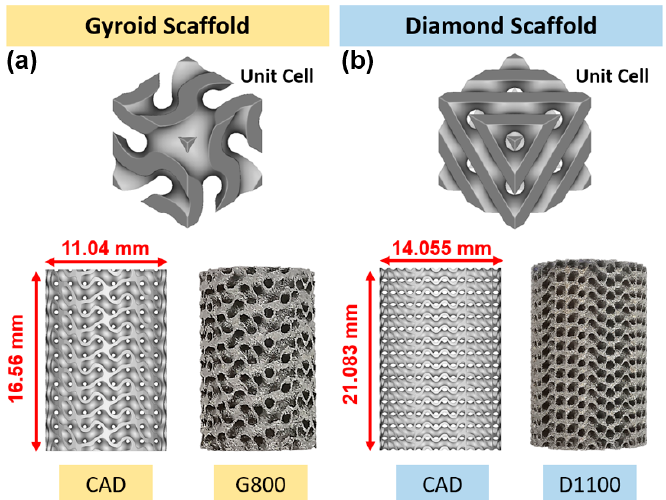
Figure 2. Three-dimensional-printed samples: ( a ) gyroid scaffold; ( b ) diamond scaffold. Sheet thickness and porosity of the TPMSs were kept constant at 300 μ m and 62%, Schoen gyroid unit respectively, for both gyroid and diamond scaffolds. Pore size was defined as the inter- connected pore size, which is the diameter of a sphere that passes through the largest pore of the porous structure. In this study, only two pore sizes were selected for morphological, mechanical and nanoindentation investigation. These were sheet TPMS gyroid unit cells with a pore size of 800 μ m (G800) and sheet TPMS diamond unit cells with a pore size of 1100 μ m (D1100). The cylindrical test specimens for G800 and D1100 were ∅ 11.04 × 16.56